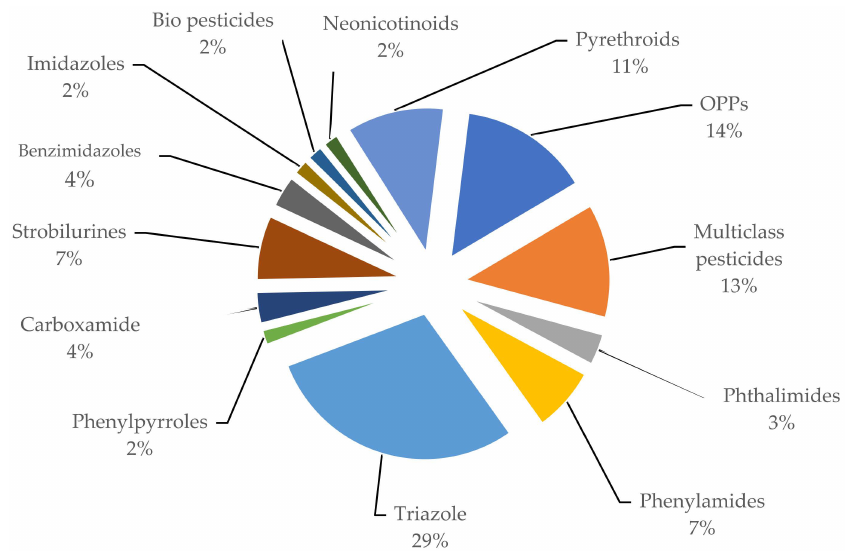
Figure 1. Classes of pesticides are most commonly used to control pests and diseases at different stages of grape